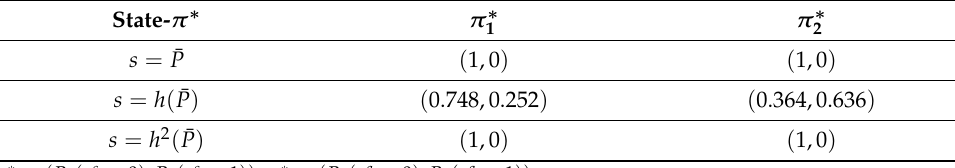
and π ∗ for reliable 2 1